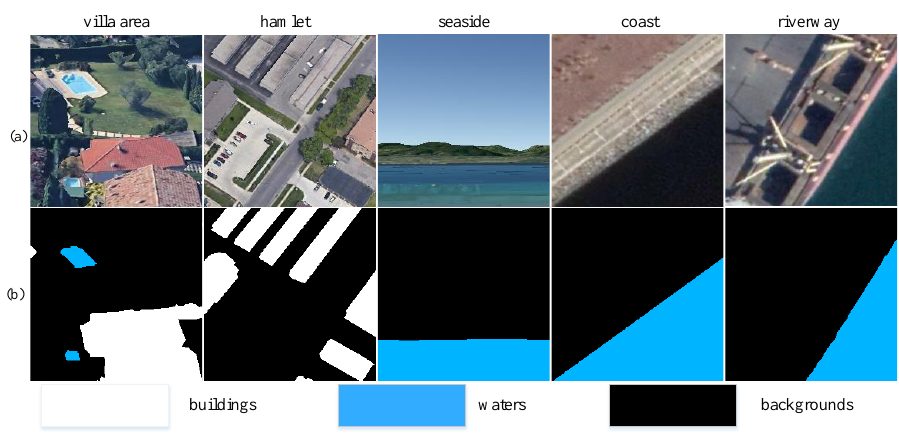
Figure 6. Land segmentation dataset: ( a ) a remote sensing image; ( b ) an artificial label. The semantic segmentation of this dataset presented great difficulties. In addition, there were some more difficult problems [35]. Buildings are stationary objects, but the differences in their height are large. The projection of the shadows of high buildings will affect the edge contour segmentation of low buildings, and the same is true for tall trees; remote sensing images with projections that are similar in appearance, indistinguisha- bility is likely. As shown in the figures below, some vehicles were similar to buildings. Although they are small in size, large areas of stationary vehicles are easily misclassified as buildings; a close-to-horizontal viewing angle can cause trees to hide the water, which would make a training set more difficult to learn; the tops of some buildings are similar in color to vegetation, and can easily be misclassified as the background; the same water area (private swimming pool) has two colors of blue and green, making it more difficult to segment water objects. In summary, this dataset is relatively difficult to learn [36], and it is also difficult to use it to perform accurate land-cover segmentation and perfect target classification, as shown in Figure 7.